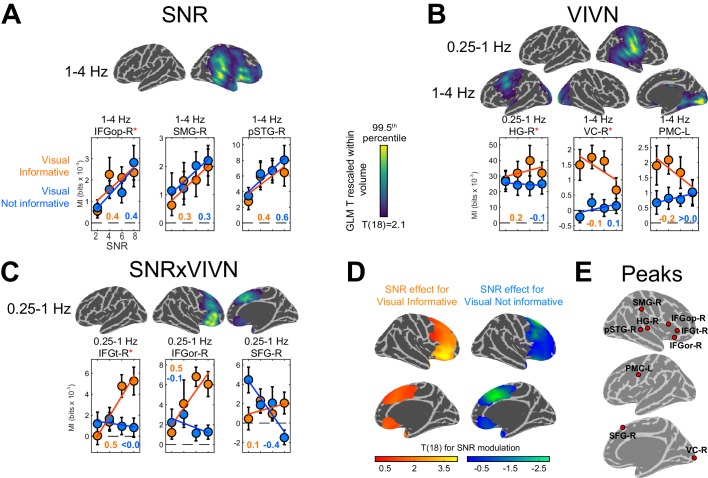
Modulation of speech-to-brain entrainment by acoustic SNR and visual informativeness.Changes in speech MI with the experimental factors were quantified using a GLM for the condition-specific speech MI based on the effects of SNR (A), visual informativeness VIVN (B), and their interaction (SNRxVIVN) (C). The figures display the cortical-surface projection onto the Freesurfer template (proximity = 10 mm) of the group-level significant statistics for each GLM effect (FWE = 0.05). Graphs show the average speech MI values for each condition (mean ± SEM), for local and global (red asterisk) of the T maps. Lines indicate the across-participant average regression model and numbers indicate the group-average standardized regression coefficient for SNR in the VI and VN conditions (>/ < 0.0 = positive/negative, rounded to 0). (D) T maps illustrating the opposite SNR effects within voxels with significant SNRxVIVN effects. MI graphs for the peaks of these maps are shown in (C) (IFGor-R and SFG-R = global T peaks for SNR effects in VI and VN, respectively). (E) Location of global and local seeds of GLM T maps, used for the analysis of directed connectivity. See also Tables 1 and 2 and Figure 3—figure supplements 1–2. Deposited data: SE_meg; SE_speech; SE_miS.